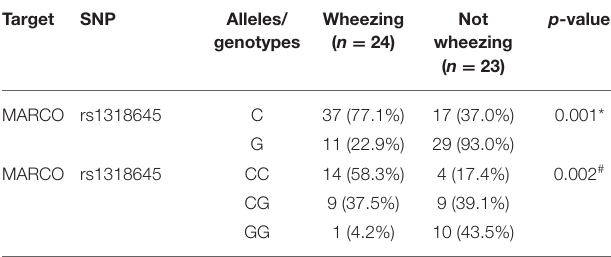
TABLE 3 | MARCO rs1318645 and recurrent wheezing during childhood.